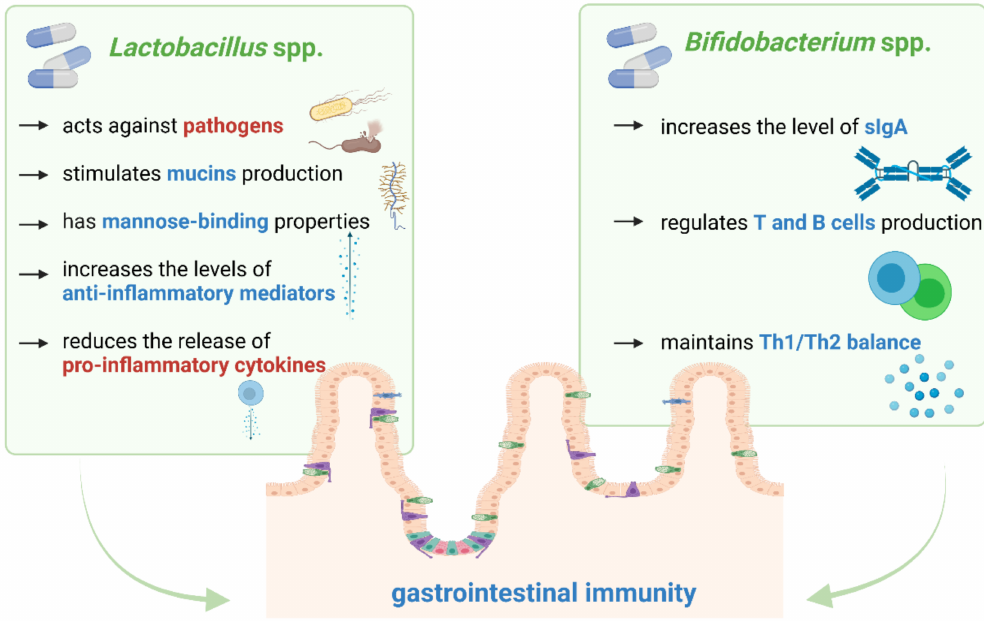
Figure 2. The main properties of Lactobacillus spp. and Bifidobacterium spp. through which they modulate gastrointestinal immunity. Our proposals based on literature